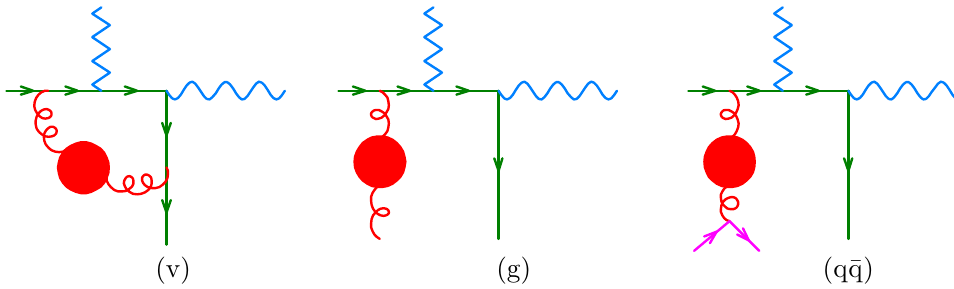
Figure 3 . A sample of the radiative corrections that need to be included in order to compute the leading large b corrections to the process of figure 0